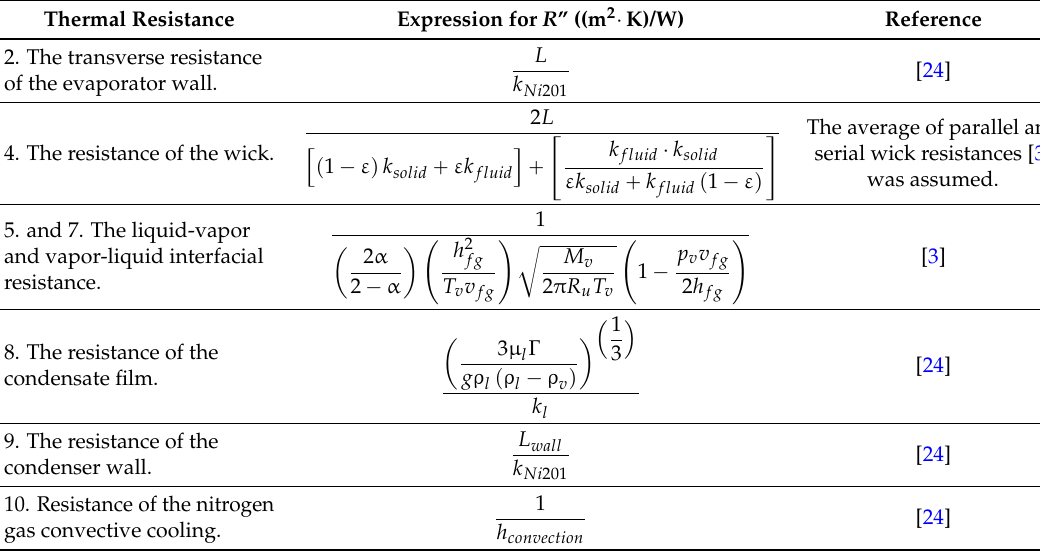
Table 2. Thermal resistances taken into